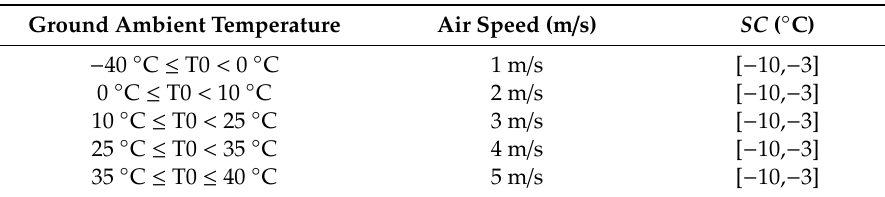
Table 3. Steady-state experimental of SC.